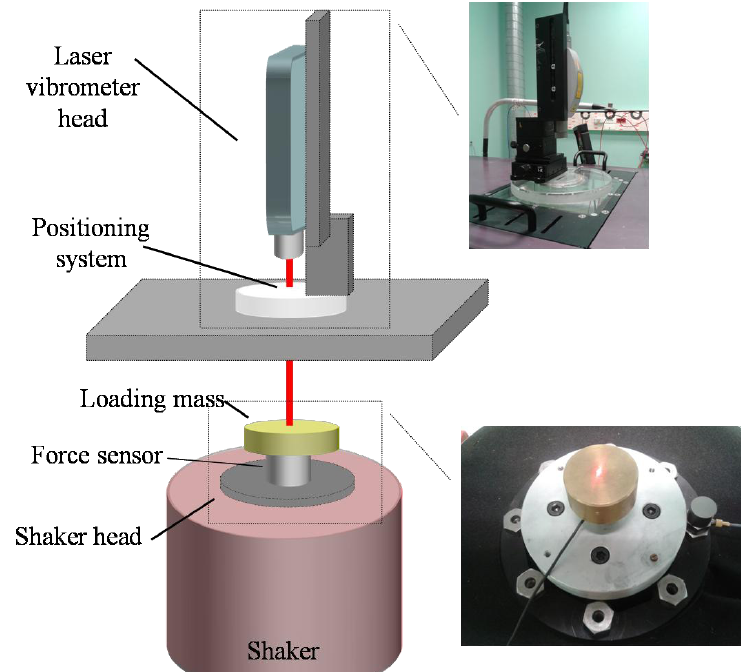
Figure 1. Calibration setup consisting of the shaker with the force sensor mounted on the shaker head and a laser vibrometer for the acceleration measurement with the positioning system for the laser beam orientation. The force sensor is loaded with an additional